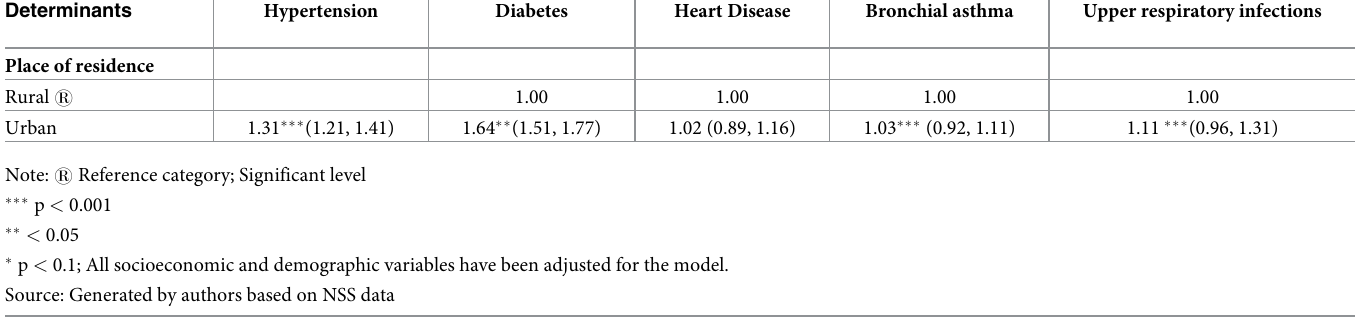
Table 4. Odds ratio and 95% Confidence Interval (CI) of top five chronic diseases associated with background characteristics in India, 2017–18. Determinants